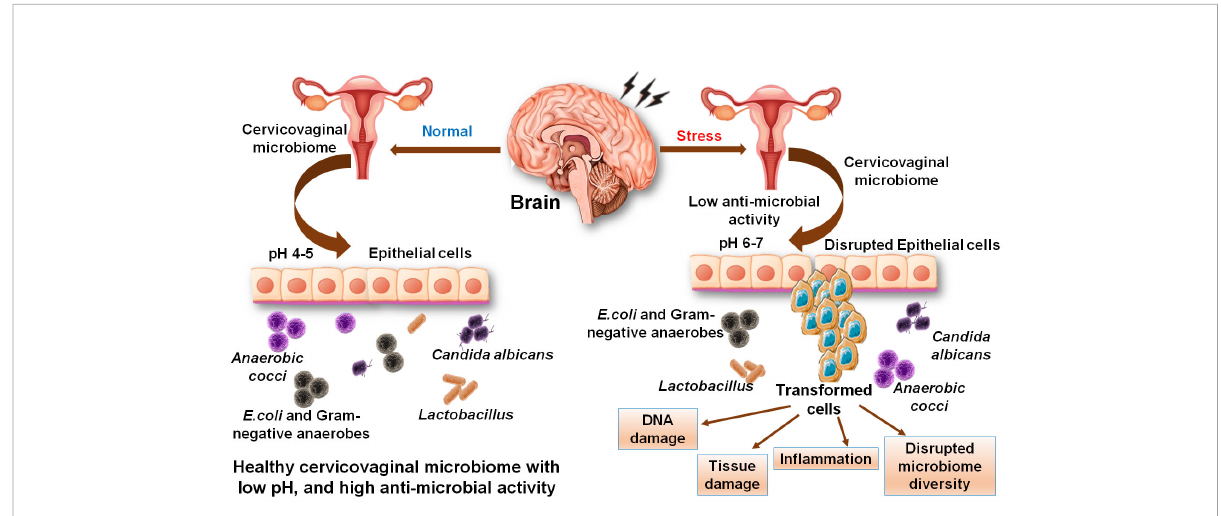
FIGURE 6 Effect of stress on cervical physiology and function and on the cervicovaginal microbiome. Stress induces alterations in the pH that causes disruption of cervical epithelium and induces migration of cells. Stress also causes alterations in the cervical microbiome and a reduction in healthy micro fl